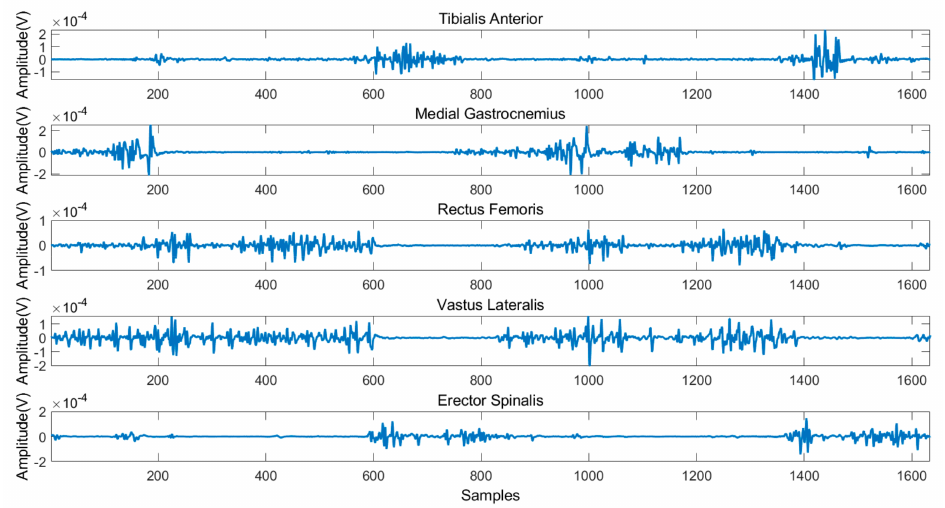
Figure 6. Typical sEMG signals during walking down the